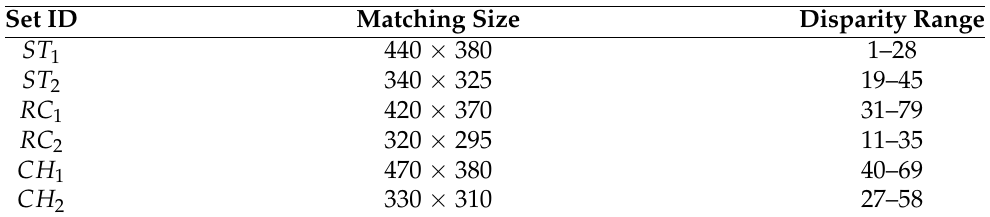
Table 1. Sizes of test data sets and the range of